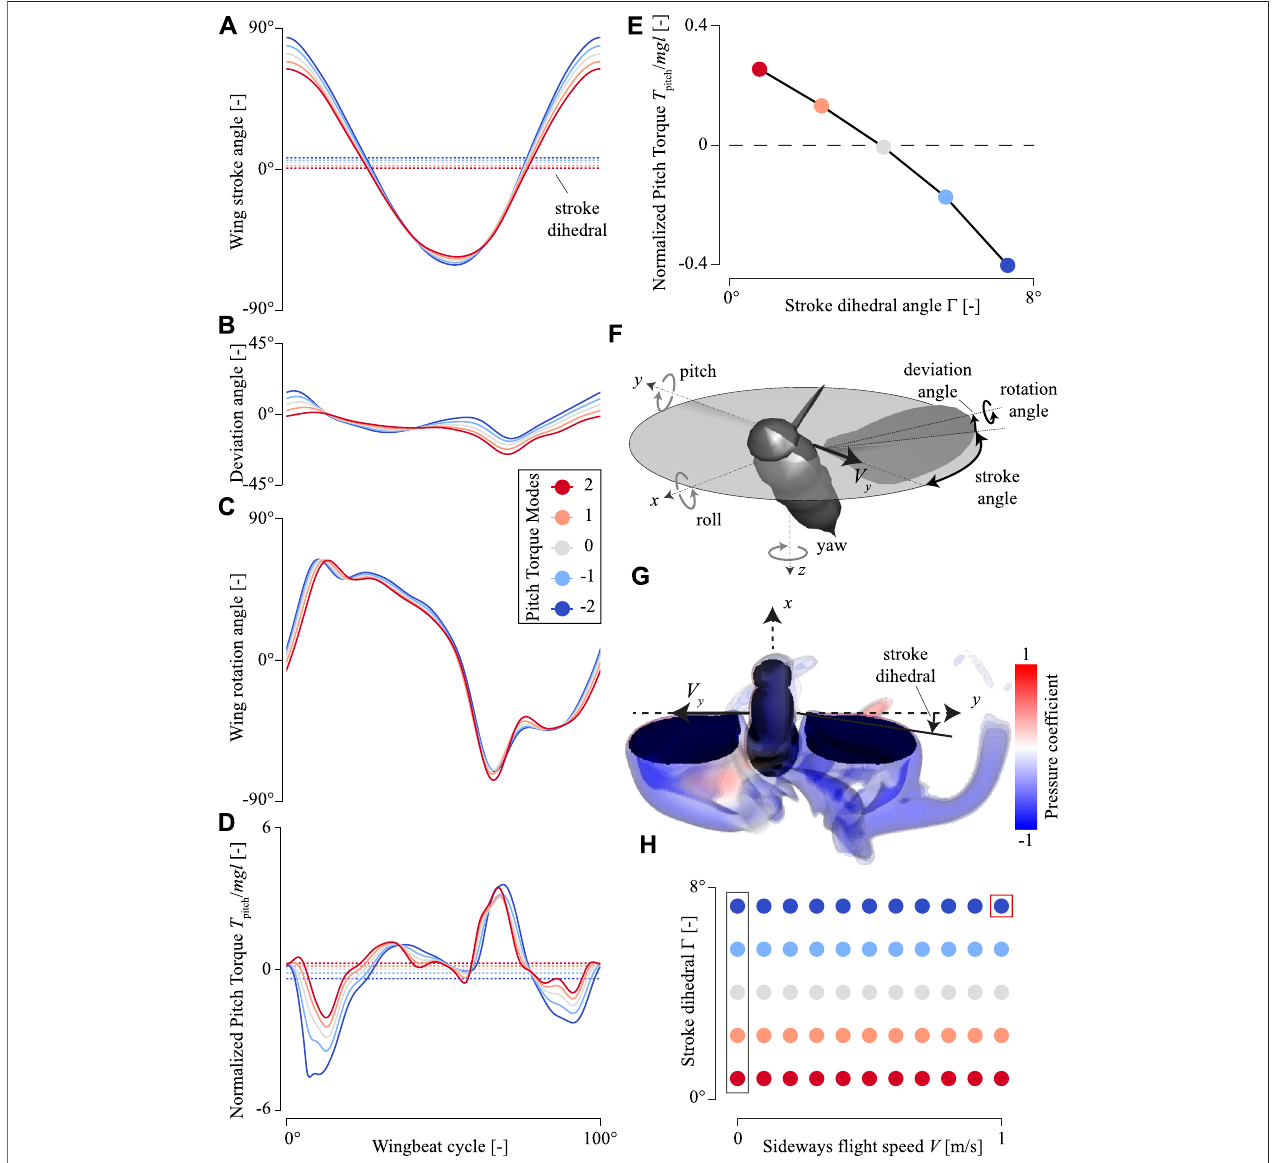
FIGURE1| Temporaldynamicsofthewing-beatkinematicsandpitchtorquesproducedbyanin-silicahoveringfruit fl y,withvariablepitchtorque-producingwing- beat kinematics (Pitch Torque Modes). (A – D) Wing stroke angle, wing deviation angle, wing rotation angle, and pitch torques, respectively. All data is color-coded with thepitchtorque-producingwing-beatkinematics(PitchTorqueModes,seelegendin(C)).Thedotedhorizontallinesin(A)and(D)showthewingbeat-averagevalues. (E) Wingbeat-average pitch torque versus stroke dihedral angle for the various pitch torque-producing wing-beat kinematics (color-code, see legend in (C)). (F) De fi nitions of the coordinate system, including the body rotations, wingbeat kinematics angles, and sideways velocity vector V used in our CFD simulations. (G) CFD simulation visualization of the air fl ow around a fruit fl y fl ying with the sideways velocity V = 1 m/s and a stroke dihedral angle Γ = 7.3 ° (Pitch Torque Mode = -2). Stroke dihedralisde fi ned asthe wingbeat-average stroke angle, asshown in (A). (H) Theparametric space of ourCFD analysis, consisting ofsideways speeds, stroke dihedral angles, and corresponding Pitch Torque Modes (color-code, see legend in (C)). Here, each dot shows the values for a single CFD simulation. The red box highlights the simulationshown inpanel(G), andthegray boxhighlightsthesimulationswithahoveringfruit fl y( V =0 m/s)and ofwhichthedataisshownin (D – E) .Here,pitchtorques are normalized with the order-of-magnitude of the weight and size of an average fruit fl y.